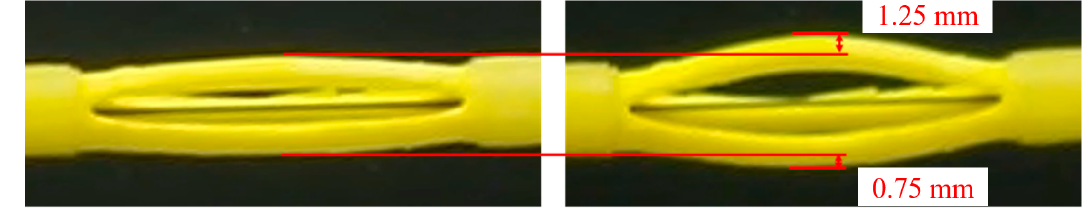
Figure 18. Setup for estimating the transversal displacement produced by the SMA wire.